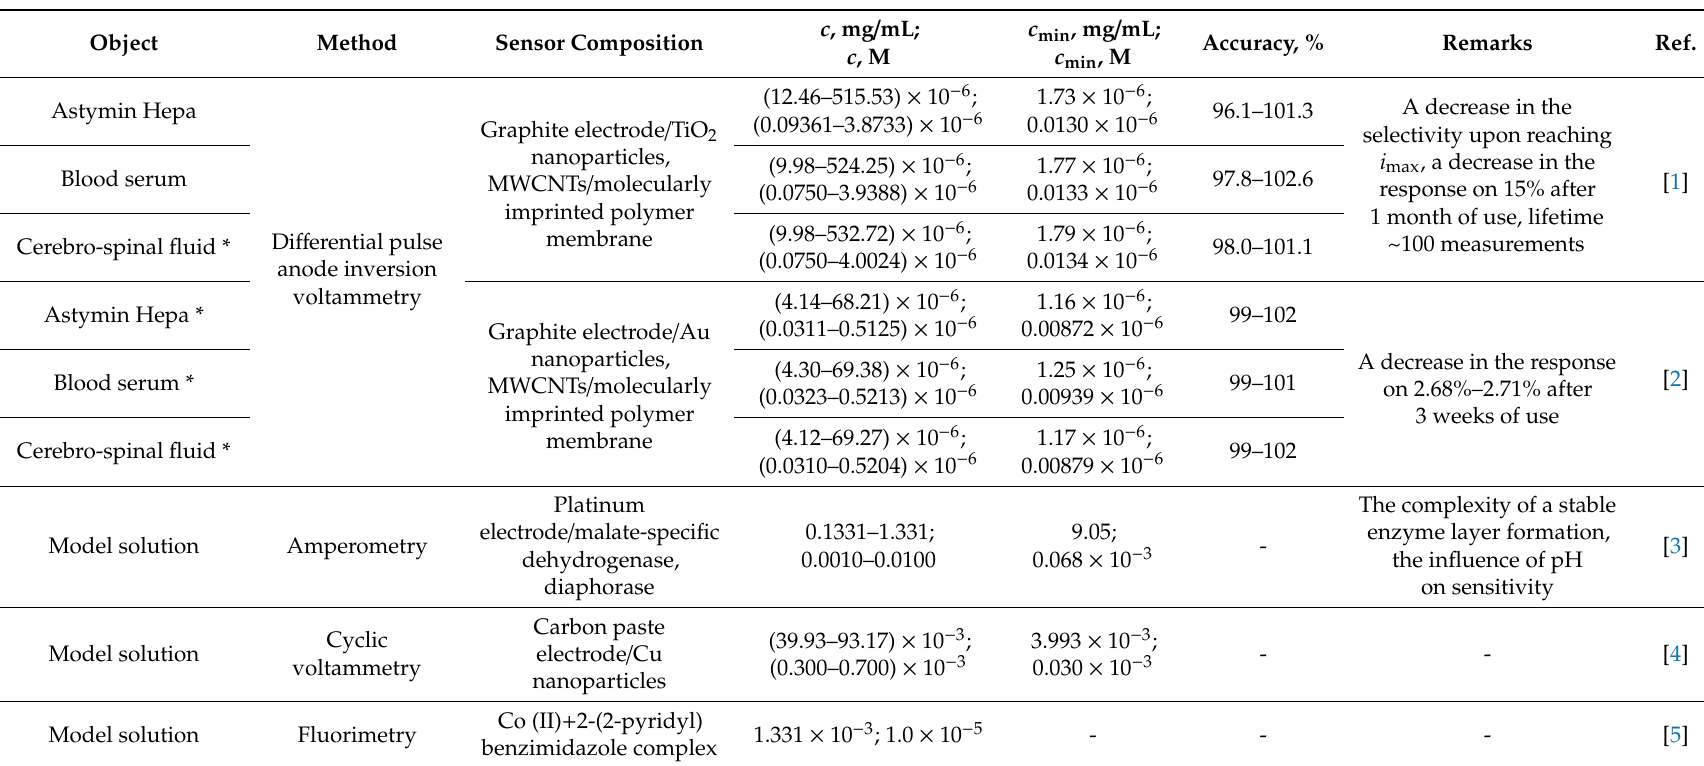
Table 1. The characteristics of sensors for the determination of L-asparaginate ions in the model solutions, pharmaceutical and physiological environments